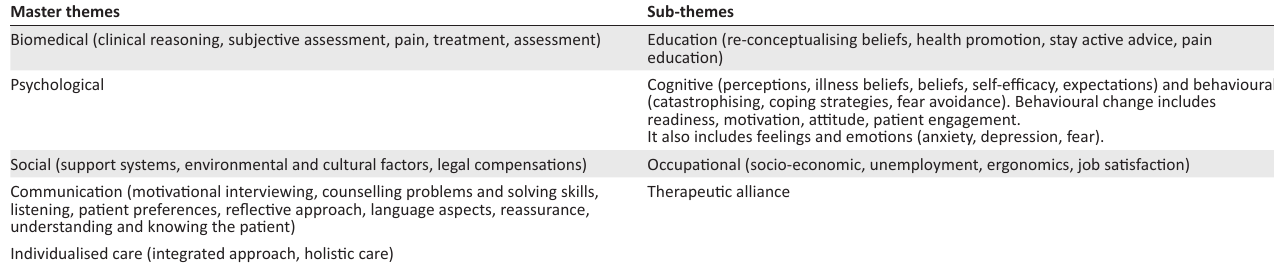
TABLE 2: Master and sub-themes of the biopsychosocial model of